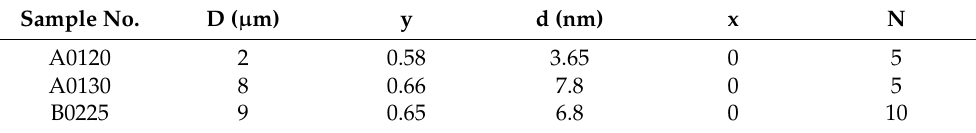
Table 1. Targeted parameters of structures under study: the thickness of the waveguide layer (D), Cd content in waveguide and barriers (y), QW thickness (d) and Cd content in (x) by in situ measurements (x (and y) values are defined as in Hg 1 − x Cd x Te), number of QWs (N). Sample No. D ( µ m) y d (nm) x N A0120 2 0.58 3.65 0 5 A0130 8 0.66 7.8 0